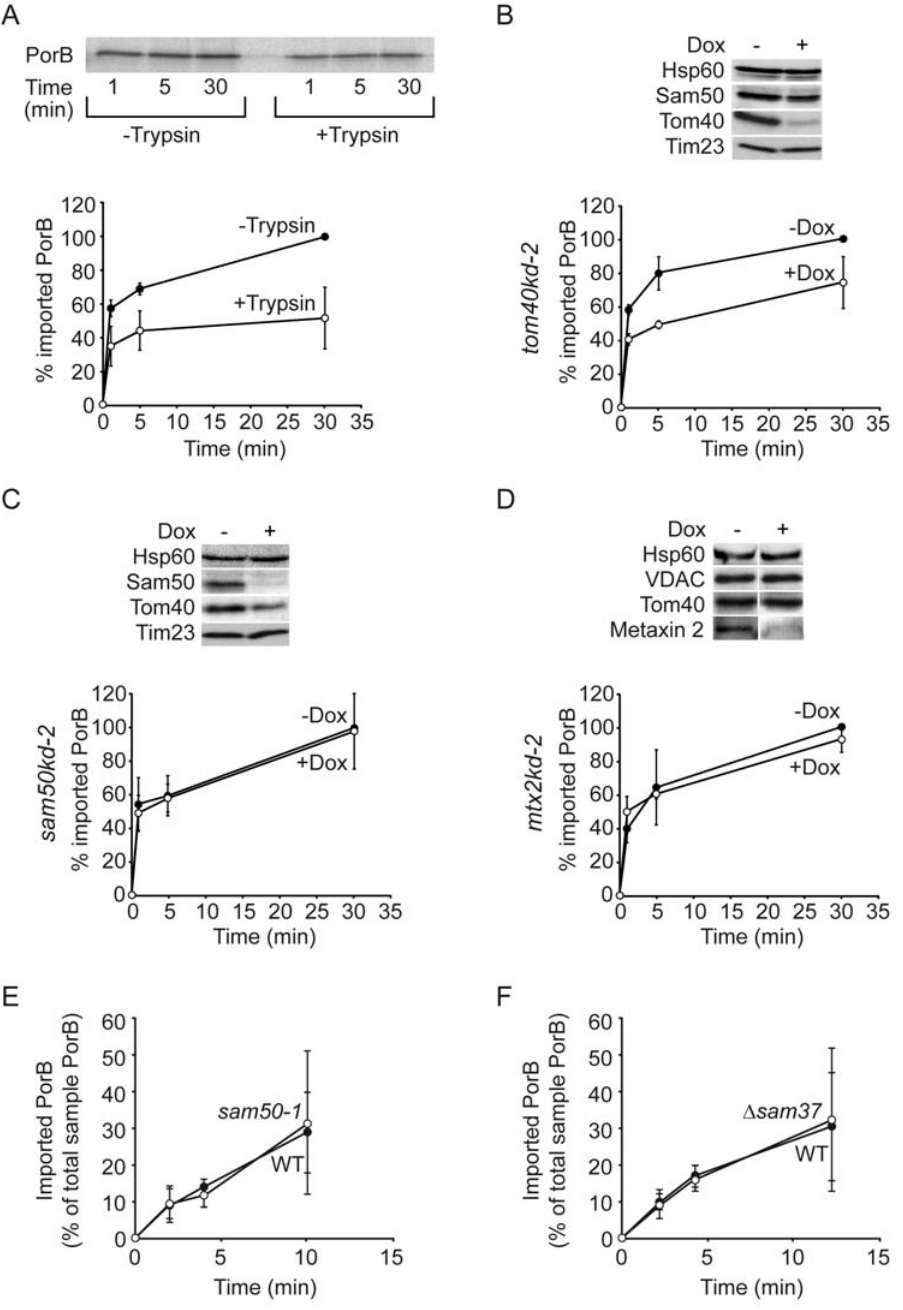
Figure 3. Import of PorB into isolated mitochondria. ( A ) Mitochondria were pretreated with 20 m g/ml of trypsin in the presence ( 2 Trypsin) or absence ( + Trypsin) of 600 m g/ml Soybean trypsin inhibitor (SBTI). In the latter ( + Trypsin) trypsin was subsequently inactivated by addition of 600 m g/ml SBTI. Treated mitochondria were incubated with a radiolabelled PorB precursor for indicated times followed by carbonate extraction at pH 11.5. The graph depicts mean 6 SDof threeindependentimport experiments. MaximumPorB import time into non- Trypsin treated mitochondria was setat 100%. ( B,C,D ) Mitochondria were isolated from tom40kd-2 , sam50kd-2 and mtx2kd-2 cell lines grown in the absence ( 2 Dox) or the presence ( + Dox) of doxycycline for 7 days, except for tom40kd-2 cells which were treated with Dox for 5 days. After the import of radiolabelled PorB for indicated times, mitochondria were subjected to carbonate extraction at pH 11.5 and SDS-PAGE. Graph depicts mean 6 SD of three independent experiments. Maximum PorB import time into mitochondria in cells not treated with Dox was set at 100%. Immunoblots demonstrate the levels of import factors in the mitochondria used for import assays and are representative of three independent experiments. ( E,F ) Import of 35 S-labelled N. gonorrhoeae PorB into mitochondria isolated from the yeast mutant strain sam50-1 , D sam37 strain and from the corresponding wildtype strains. The amount of imported PorB was normalized against the total amount of PorB in the import reaction. Graph depicts mean 6 SD of four independent experiments.